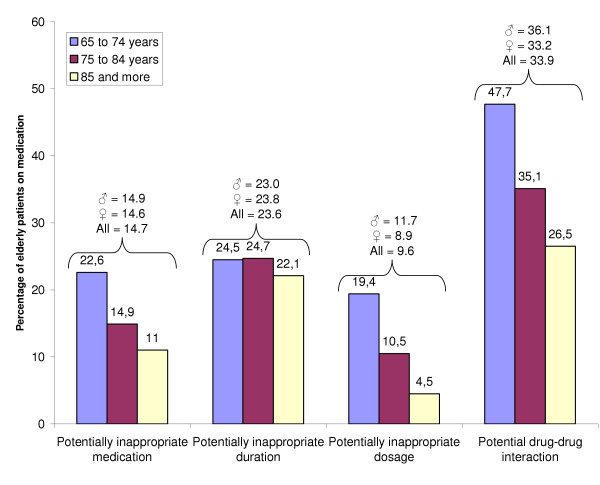
Potentially inappropriate prescribing including inappropriate medication, dosage, duration and potential drug-drug interaction among three age-groupsof long-term care elderly (N = 2,481) ♂ = male ♀ = female